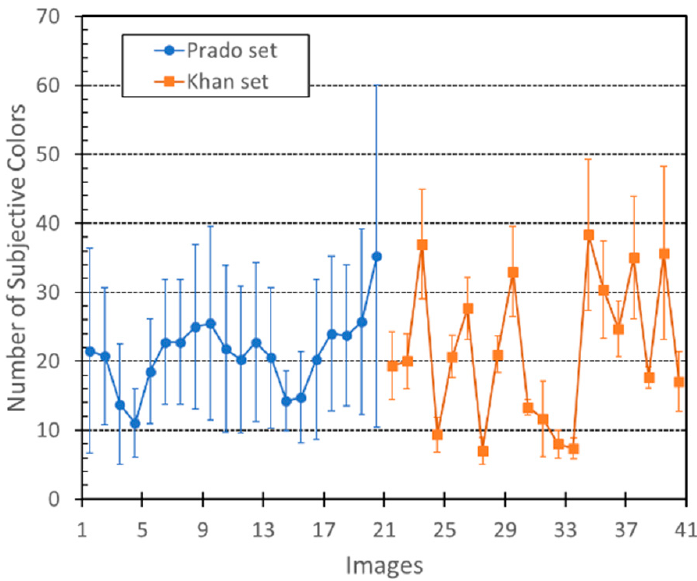
Figure 4. Average numbers of subjective relevant colours obtained for all painting images and all observers.